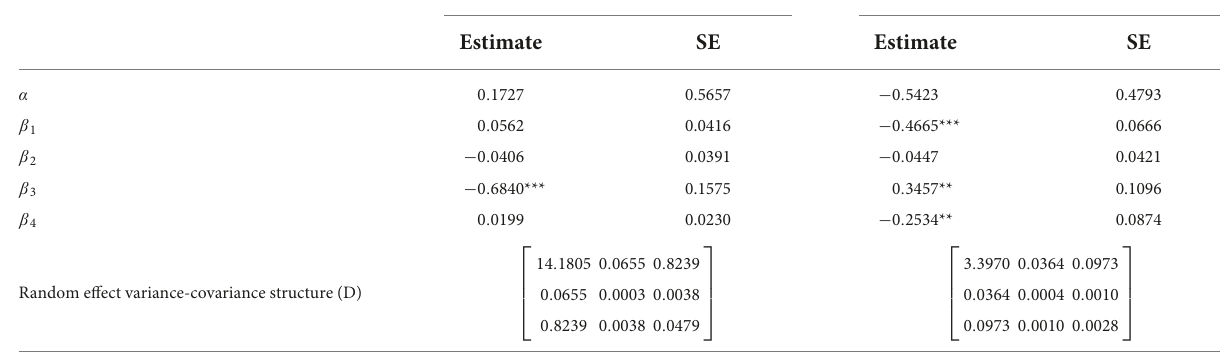
TABLE 3 Parameter estimation of the optimal mixed-effects model.